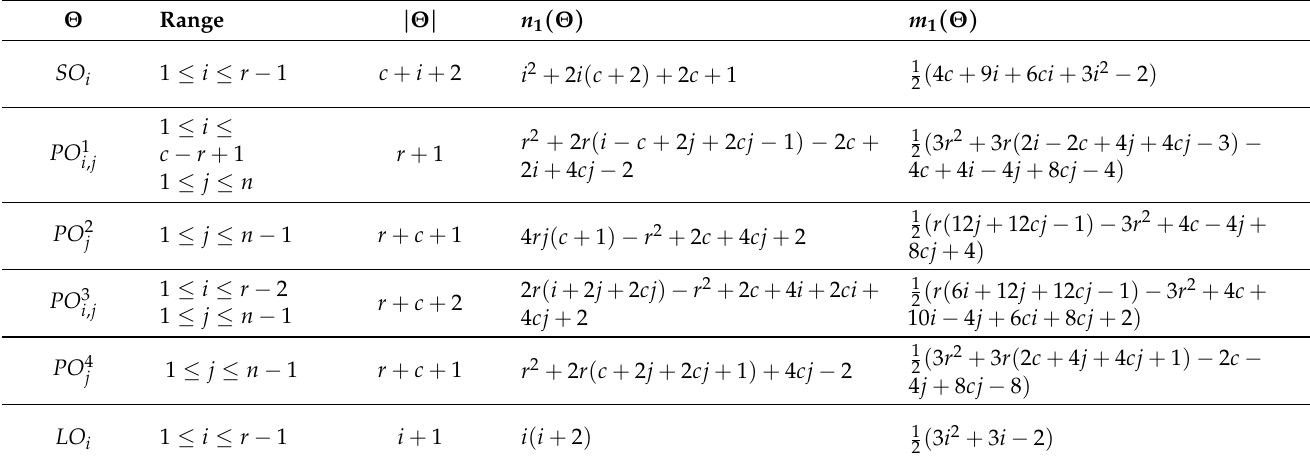
Table 2. O-type Θ -classes of WNR ( r , c , n )